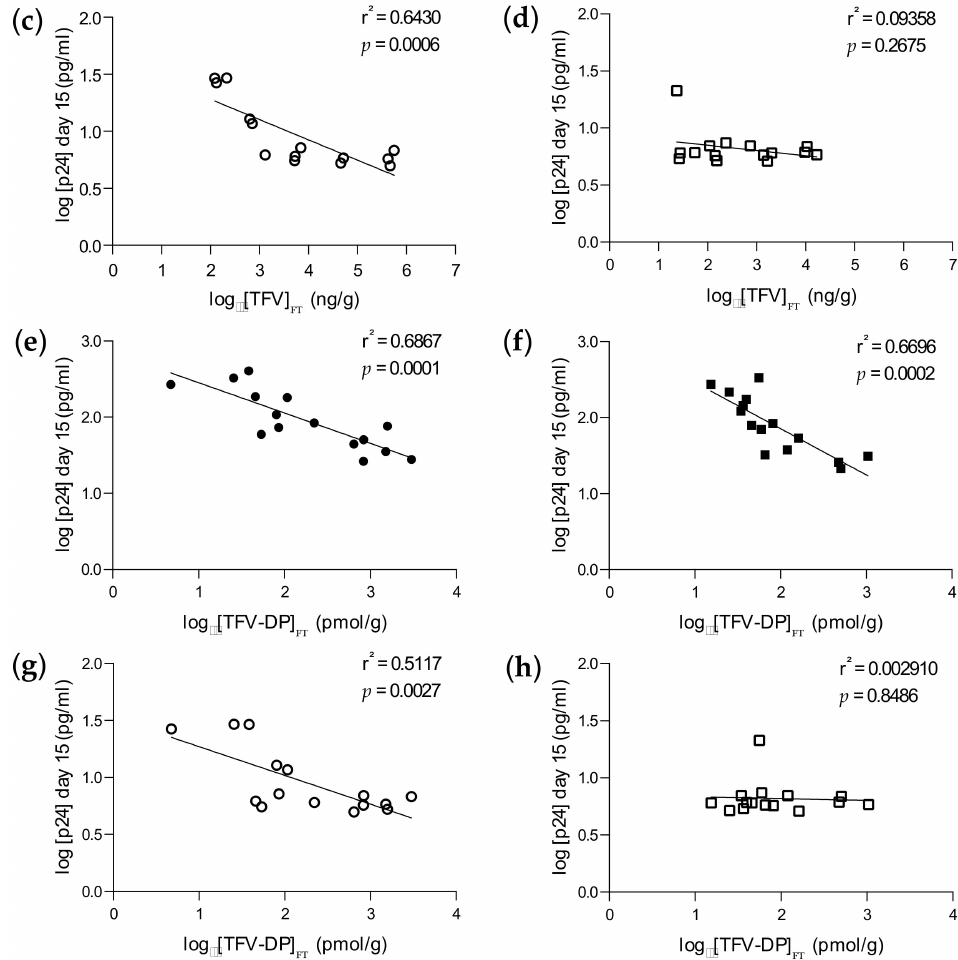
Figure 5. PK–PD correlations in foreskin explants. Pearson correlation analysis was performed between tissue explant concentrations of TFV ( a – d ) or TFV–DP ( e – h ), and p24 levels in culture supernatants 15 days post-ex vivo challenge with HVT ( a , b , e , f ) or LVT ( c , d , g , h ) following ex vivo • dosing with TFV ( , ) or TAF ( (cid:4) , (cid:3) ) and challenge with HVT (solid symbols) or LVT (open (cid:35) symbols). Data are the means (SEMs) from three independent experiments performed in